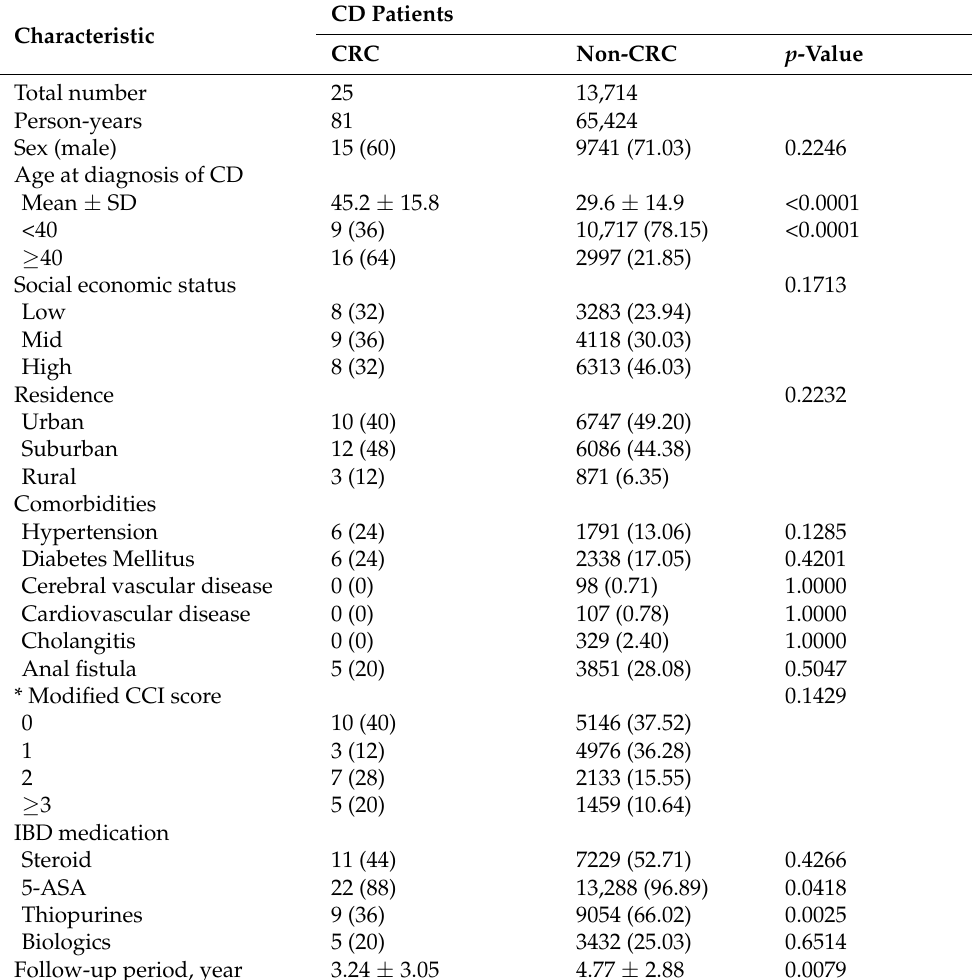
Table 5. Characteristics of CD patients by CRC.